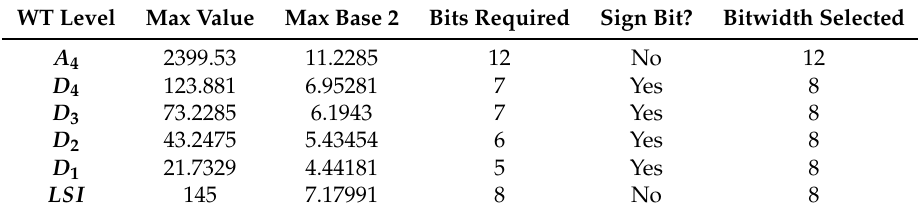
Table 2. Wavelet coefficient memory requirements.